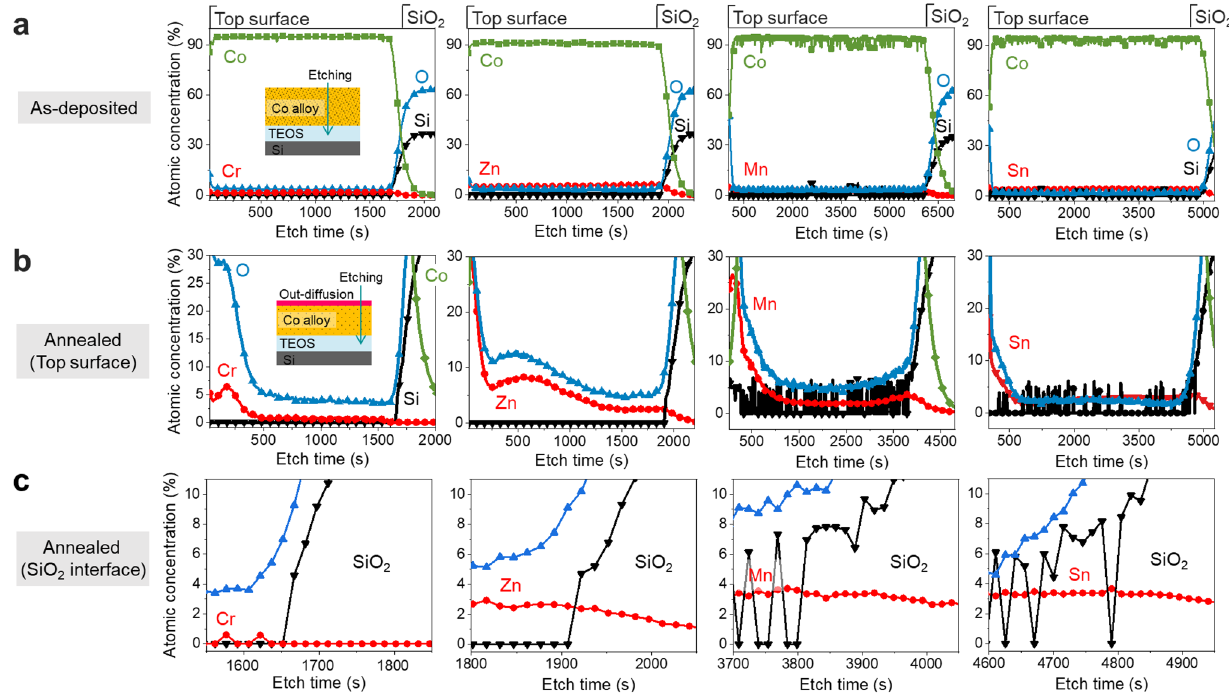
Figure 2. XPS depth profiles of Co alloy thin films; Co–Cr, Co–Zn, Co-Mn, and Co–Sn. ( a ) as-deposited thin films. ( b ) top surface profile after annealing at 450 °C. ( c ) alloy dopant profiles at the SiO 2 interface after